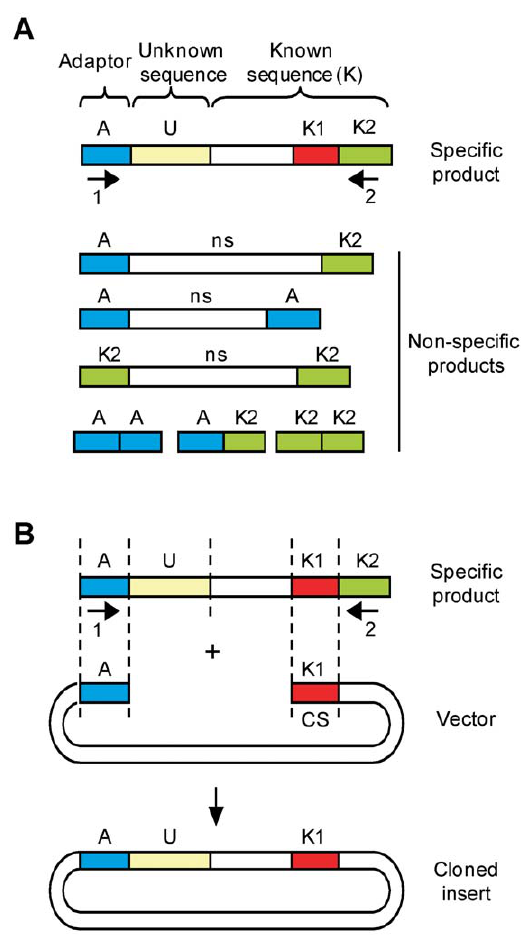
Figure 1. Principle of the QC cloning strategy. ( A ) PCR products amplified to identify unknown sequences flanking a region of known sequence typically consist of an adaptor sequence (A) attached to the end of the unknown sequence (U) followed by a region of known sequence (K). The PCR product is amplified with two primers (1 and 2) that are homologous to the adaptor sequence and to part of the known sequence (region K2). Non-specific products (ns) and primer dimers can also be obtained during PCR amplification. ( B ) The fragment is cloned by homology with a linearized vector that is homologous to the adaptor sequence at one end and to a sequence from the known region (K1, called the CS in the cloning vector) at the other end. Since sequence K1 does not overlap with sequence K2, non-specific products and primer dimers cannot be cloned.